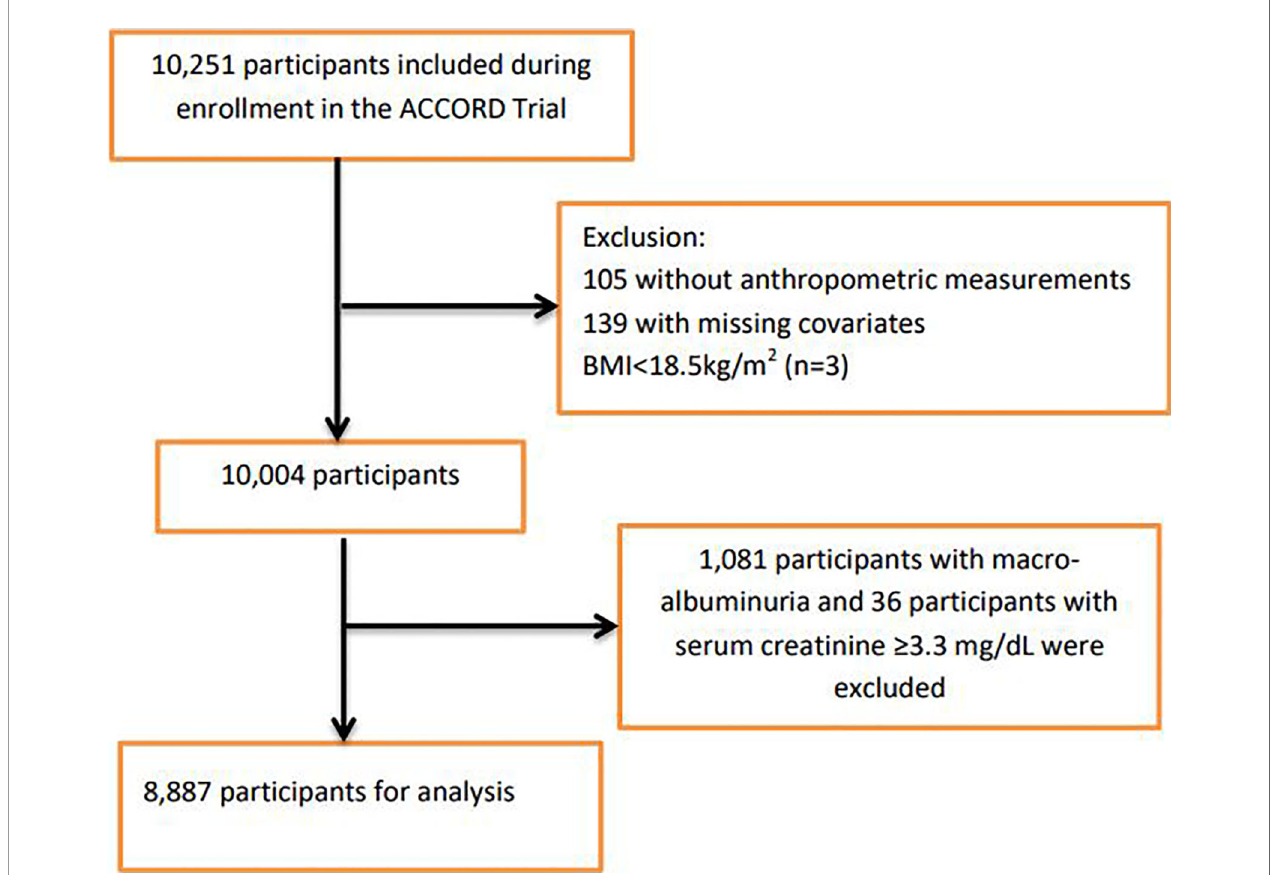
FIGURE 1 | Flowchart for participant